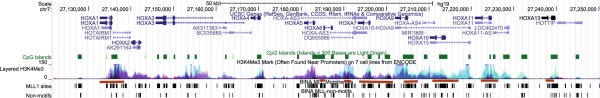
Localization of CGIs and MLL1 morphemes in DNA segments encompassing human HOXA locus. Horizontal green bars mark the position of CGIs. Horizontal brown bars mark MLL1 binding segments observed in ChIP assays [47]. Track-labeled “MLL1 sites” marks morpheme positions; “non-motifs” mark the position of sequences not found in results of SELEX assays [24]. Track-labeled “Layered H3K4me3” shows the position of H3K4me3 marks [59].